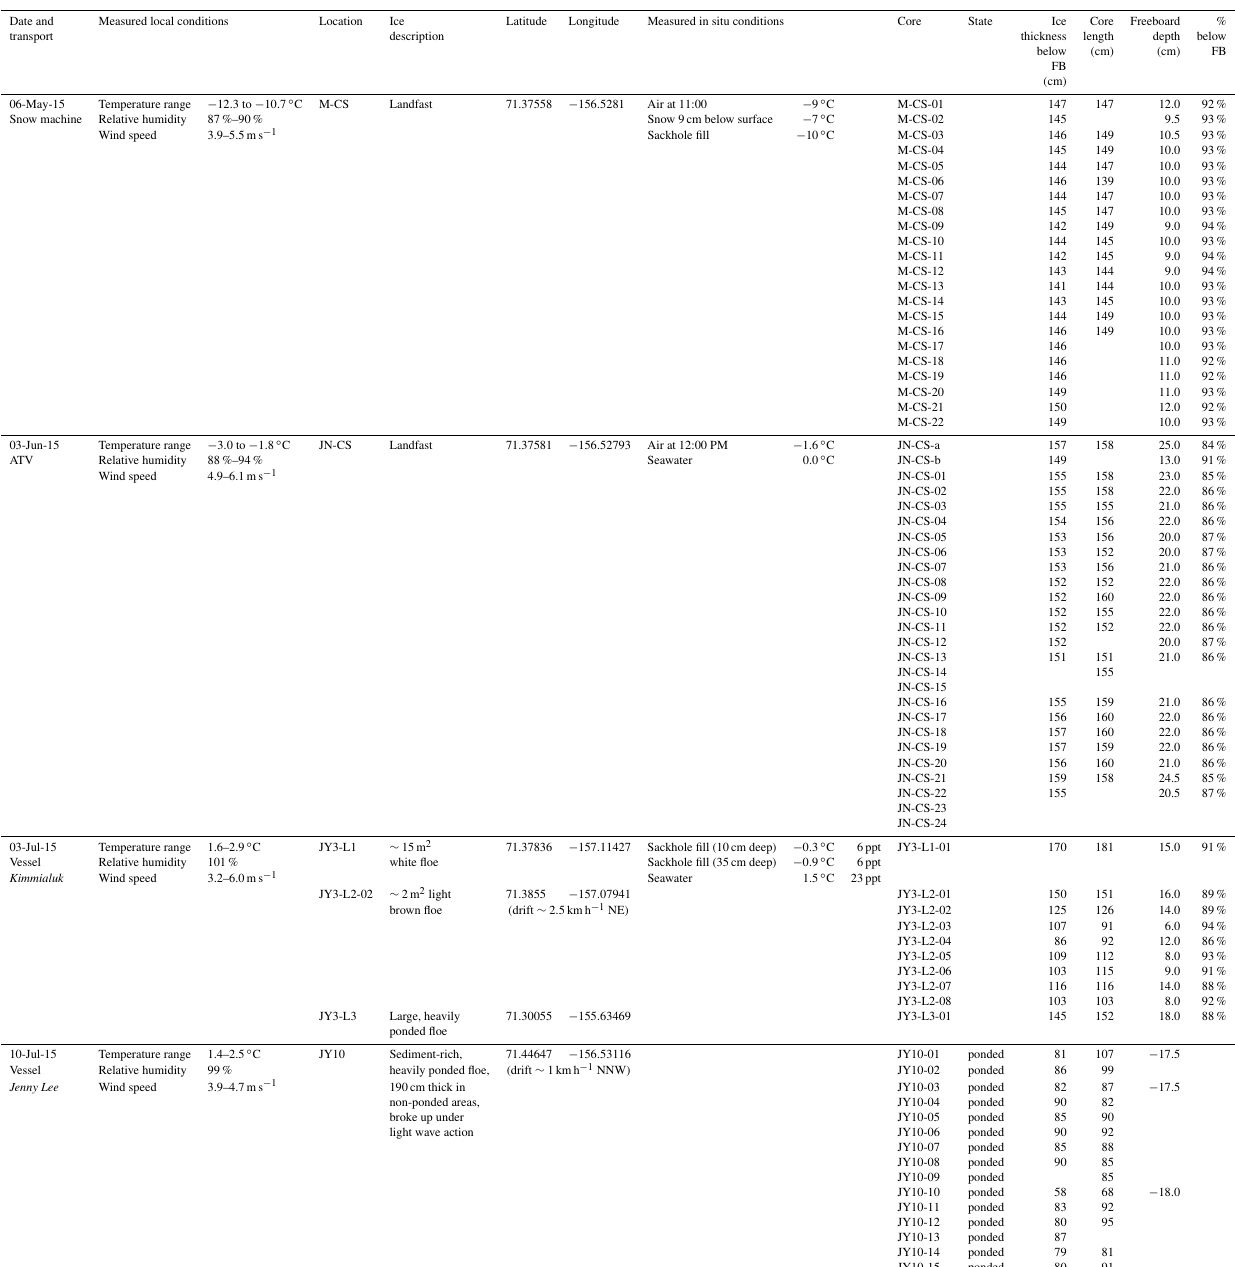
Table 1. Collected ice cores, sample locations, and in situ conditions. Measured local conditions are ranges of hourly averages of mete- orological data measured between 10:00 and 18:00 local time from the NOAA Earth System Research Laboratory Barrow Atmospheric Baseline Observatory (BRW) 8km NE of Utqia˙gvik (lat 71.3230, long − 156.6114; https://www.esrl.noaa.gov/gmd/obop/brw/, last